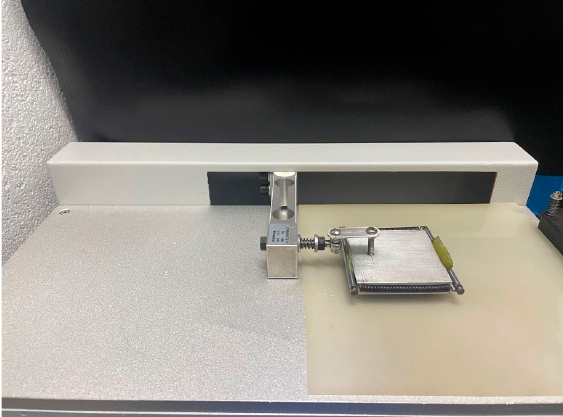
Figure 12. Schematic diagram of friction characteristic test.